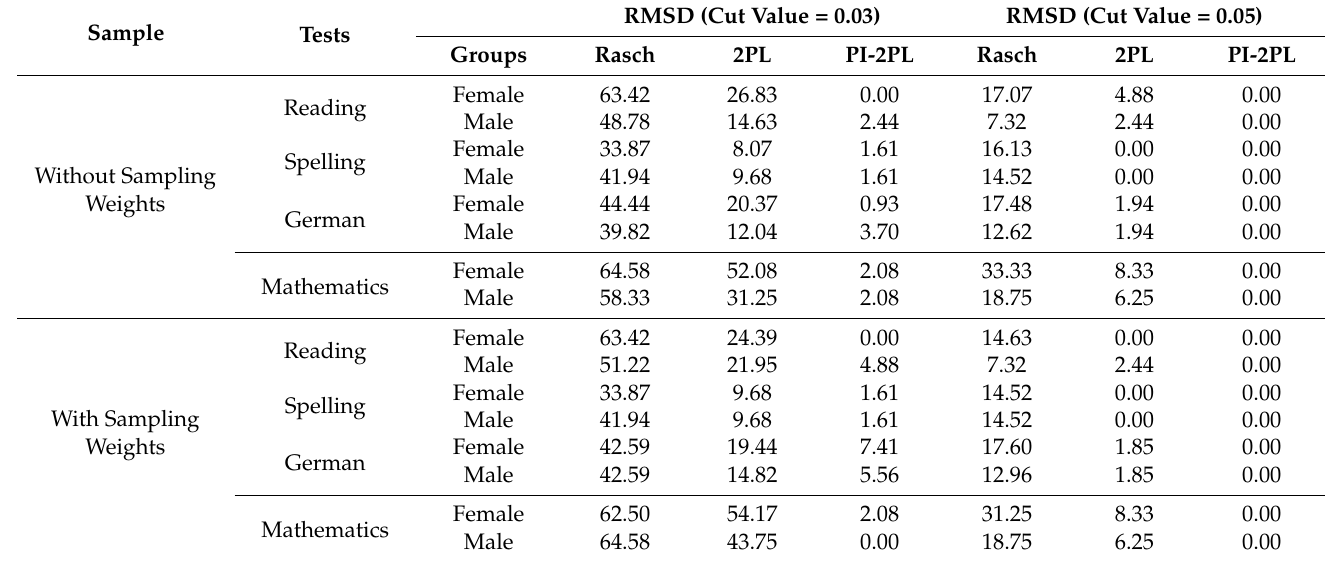
Table 5. Proportion (%) of misfit items among female and male students on tests.